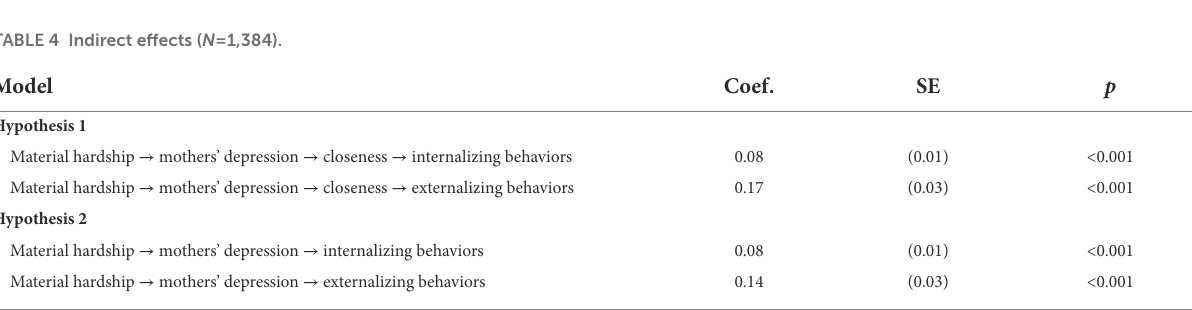
TABLE 4 Indirect effects ( N =